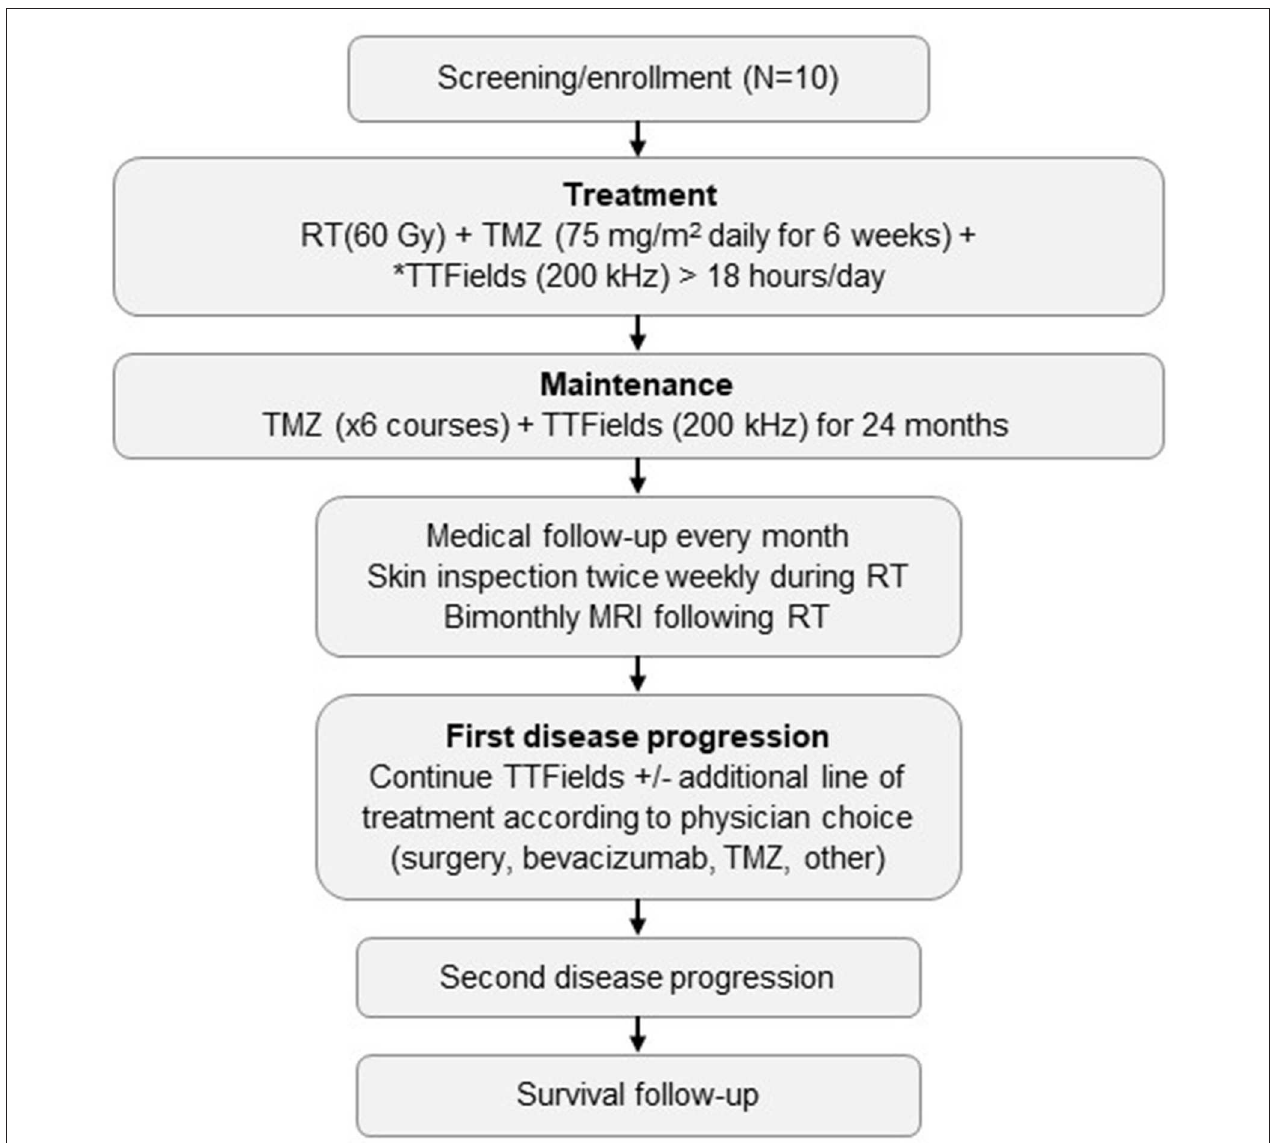
FIGURE 1 | Study schema.*Starting ≥ 2 weeks before brain surgery and prior to or at the beginning of RT plus TMZ. TTFields are to be administered for > 18 hours/day, with daily removal of transducer arrays during RT delivery. MRI, magnetic resonance imaging; RT, radiation therapy; TMZ, temozolomide; TTFields, Tumor Treating